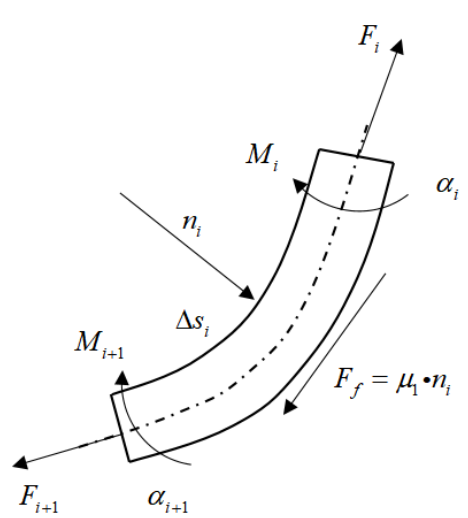
Figure 5. Small drill string sections analysis diagram.